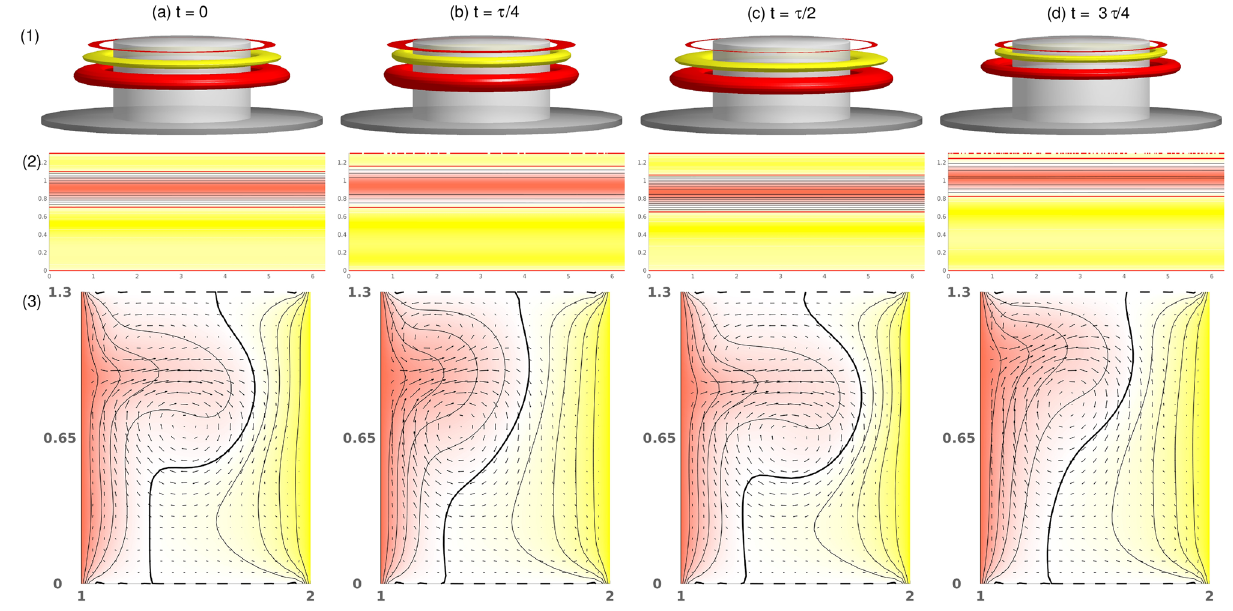
0 , as shown in Fig. 5 with isosurfaces η =